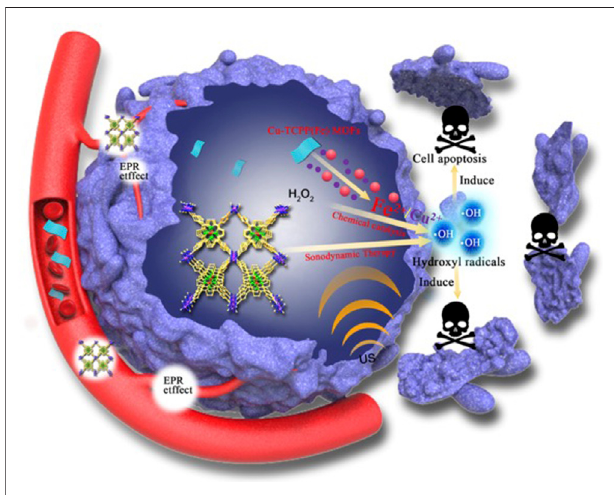
FIGURE 1 | Schematic illustration of the synergistic SDT/chemical catalytic-therapeutic mechanism of Cu-TCPP(Fe) MOFs against cancer.